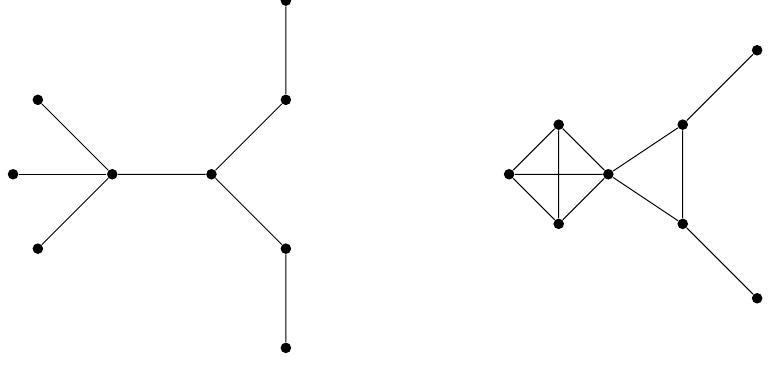
Figure 1: A tree (left) and its line graph